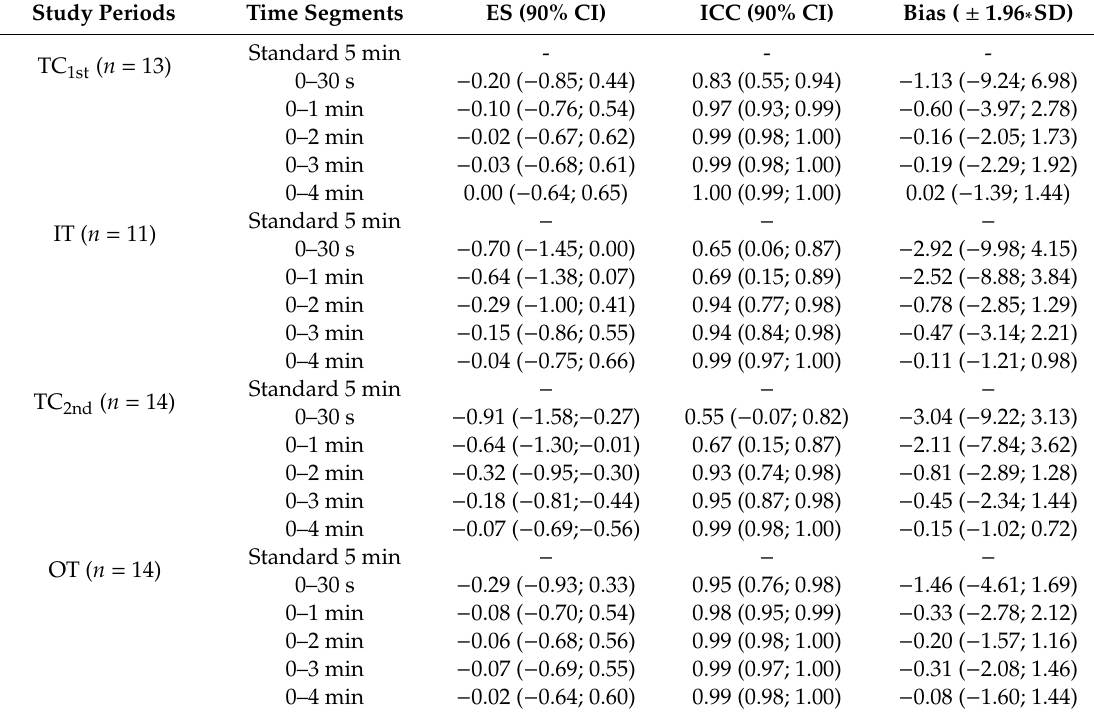
Table 3. Coe ffi cient of variation of natural logarithm of the root mean square di ff erences between adjacent normal R-R intervals during 30 seconds, 1 minute, 2 minute, 3 minute, 4 minute, and 5 minute of time segments in first training camp, invitation tournament, second training camp, and o ffi cial